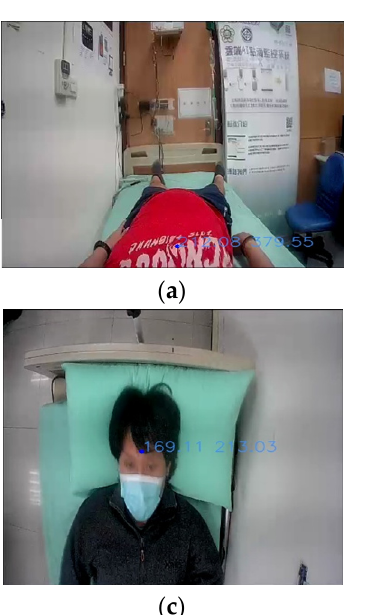
Figure 2. System prototype: ( a ) system with mobile stand; ( b ) camera capturing a horizontal view; ( c ) camera capturing a vertical view.